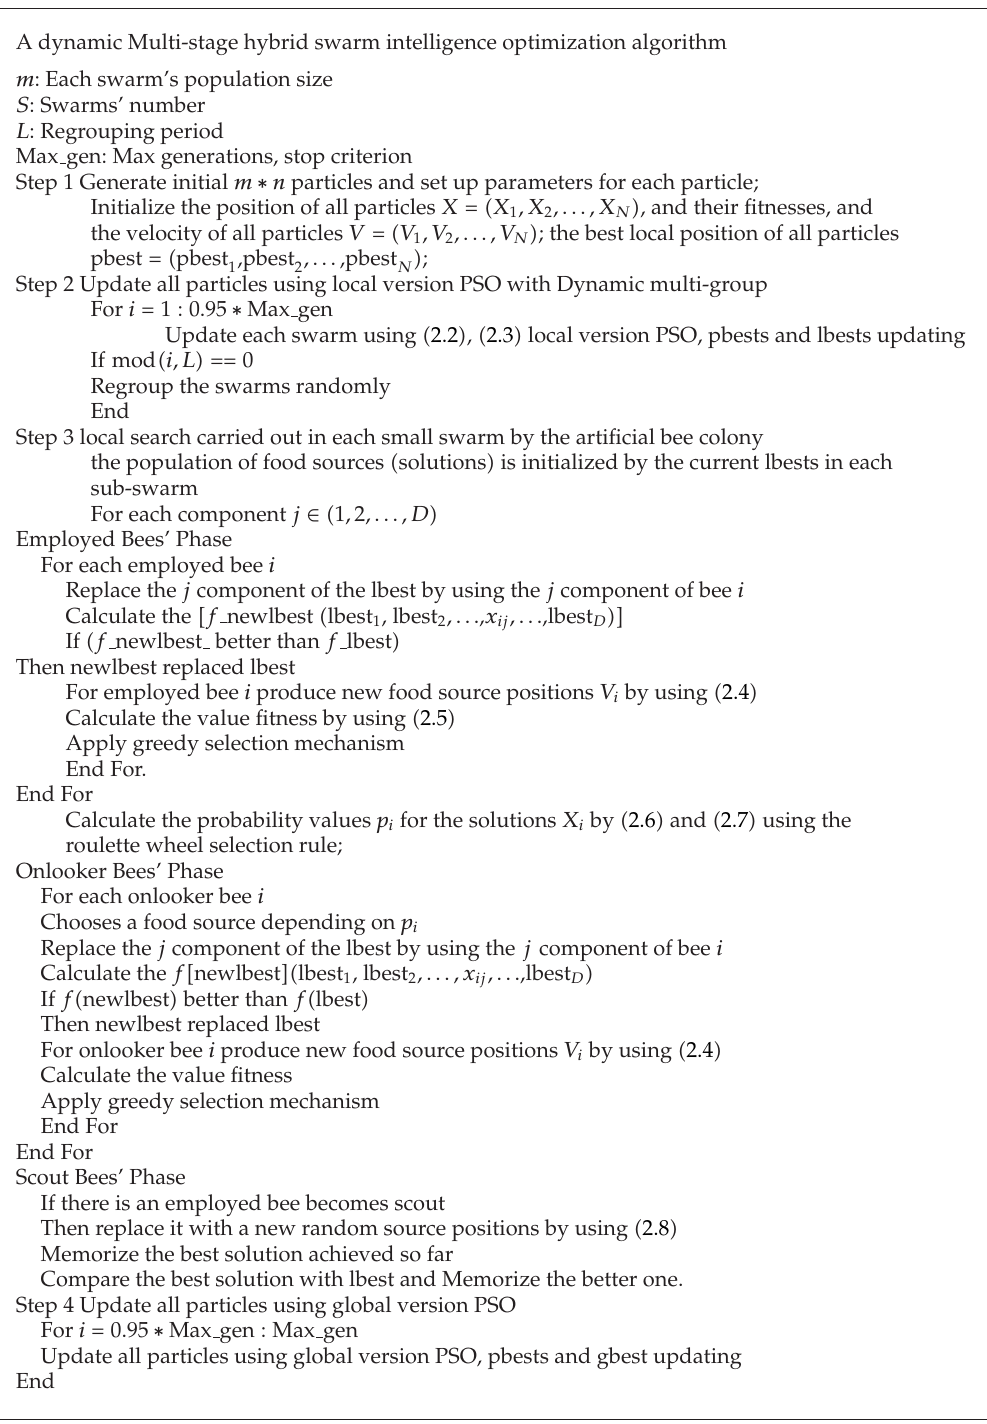
Pseudocode 1: Pseudocode of